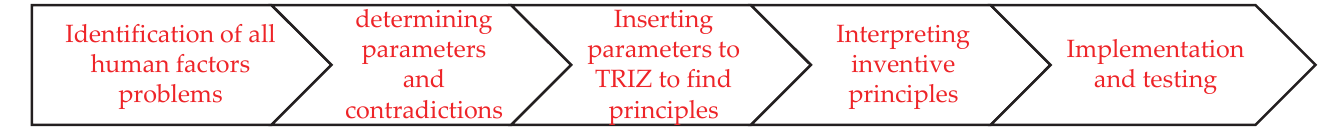
Figure 1. TRIZ methodology for solving human factors (adopted from [12]).